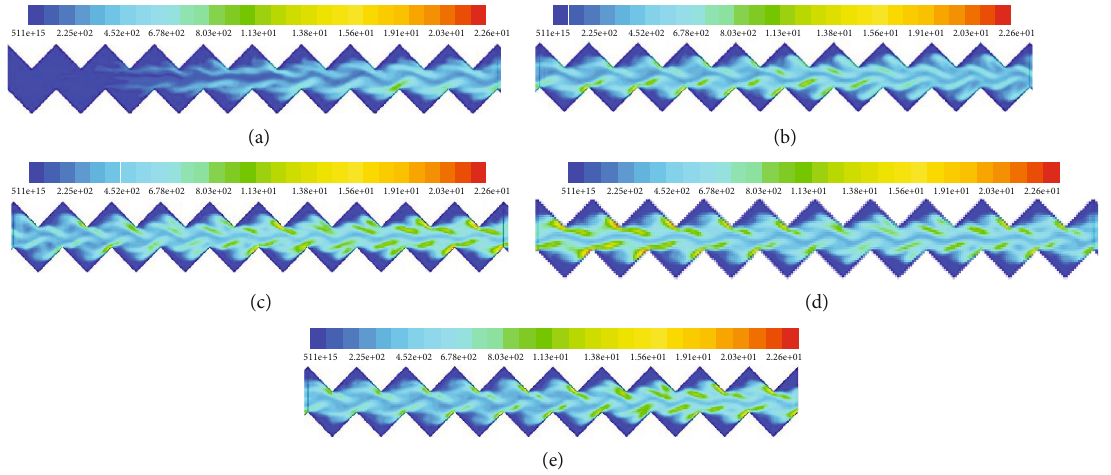
= 0 mm to X = 20mm ; (b) X 1 1 = 80 mm to X = 100mm 1 1